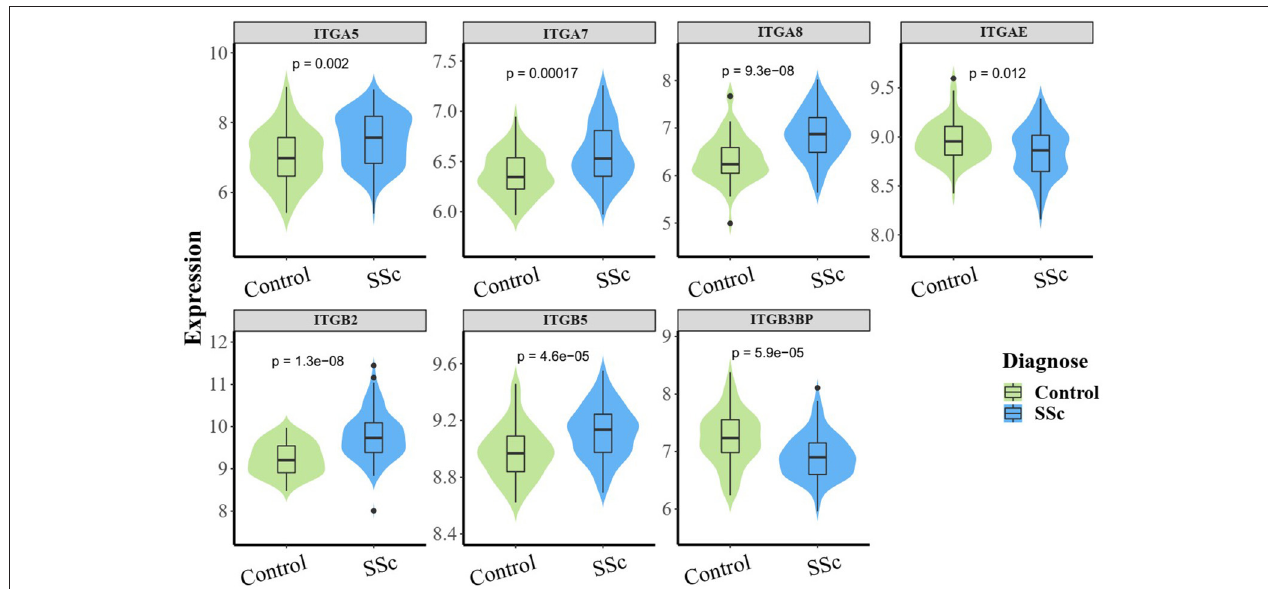
FIGURE 1 | The aberrant mRNA expression of integrin genes in SSc patients. Differentially expressed violin plot of integrin family genes in skin samples of patients with SSc (89 SSc vs. 61 normal control). SSc, systemic sclerosis.